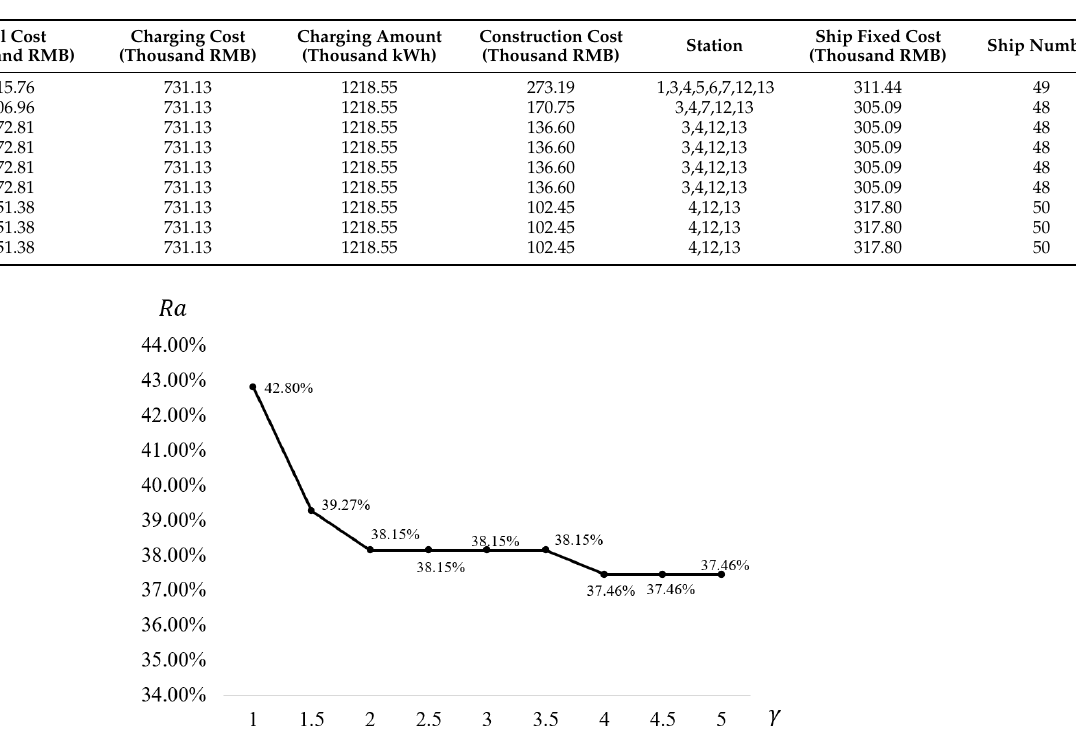
Table 9. The impact of battery capacity.